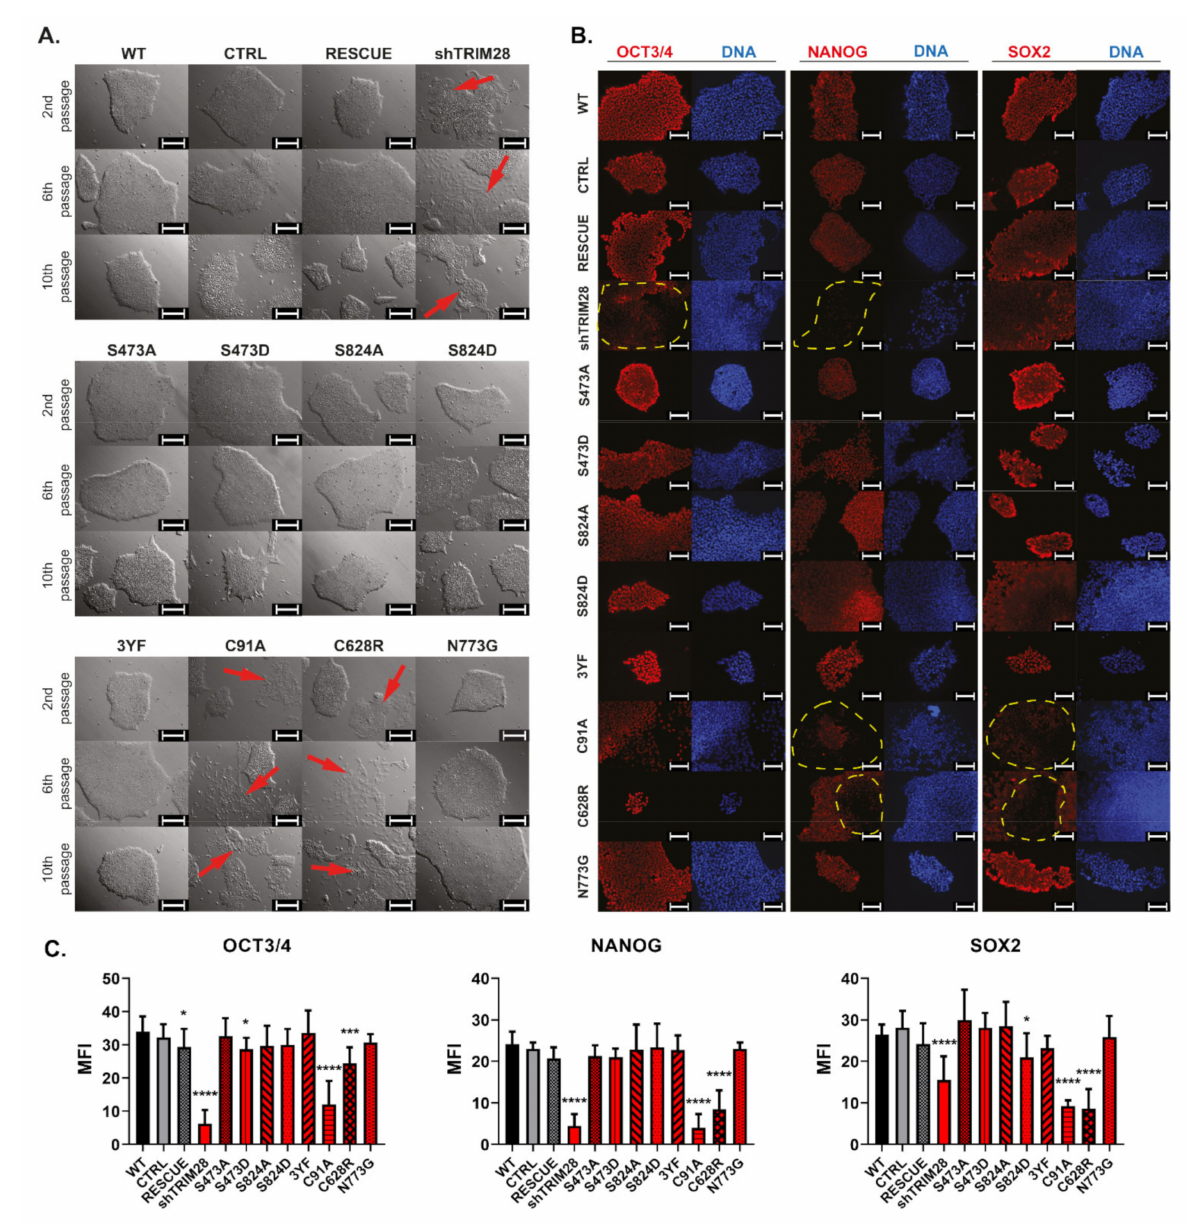
Figure 4. Mutations of RING and PHD domains influence iPSC morphology and pluripotency marker expression. ( A ) Morphology of iPSC colonies was visually inspected every day for 10 passages after LV transduction. Pictures show representative morphology after the 2nd, 6th, and 10th passage. Scale bar: 200 µ m. ( B , C ) Loss of endogenous pluripotency markers expression in differentiating populations (shTRIM28, C91A, C628R) evaluated by immunofluorescence staining against OCT3/4, SOX2, and NANOG (red—pluripotency markers; blue—DAPI). Scale bar: 100 µ m. Graphs represent the quantitative analysis of mean MFI (SD), n = 3. Statistical analysis performed with one-way ANOVA and a post-hoc Dunnett’s test; p ≤ 0.05 (<0.0001 ****; 0.0001–0.001 ***; 0.01–0.05 *; ≥ 0.05 not